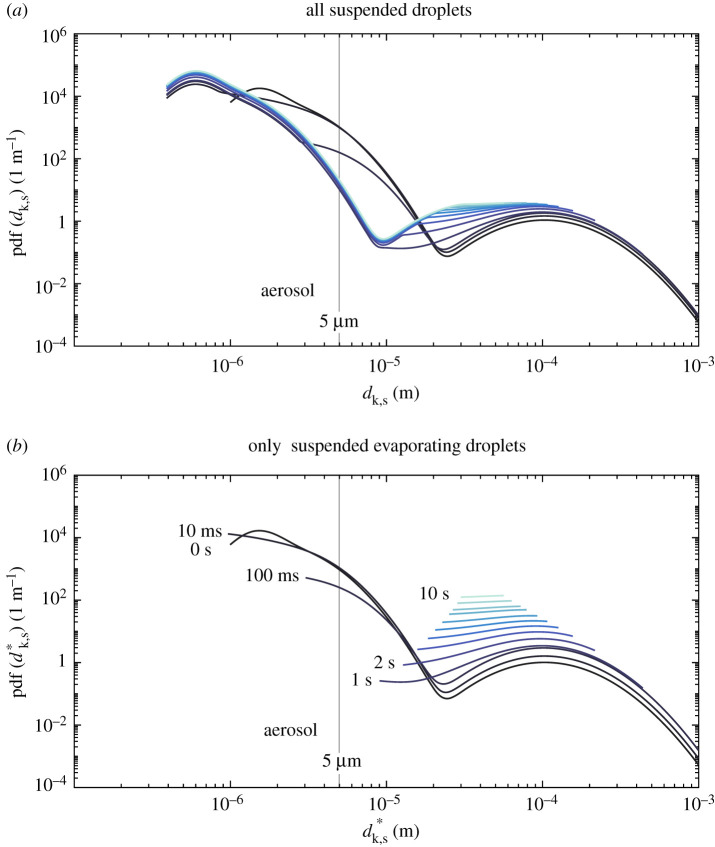
Evolution of the probability density function of droplet size from speaking for various times after droplets are exhaled. In (a) all suspended droplets are considered, and (b) only suspended evaporating droplets are considered (i.e. ‘fully evaporated droplets that have reached their equilibrium size are removed from the pdf’)—T = 20°C, RH = 60%. (Online version in colour.)